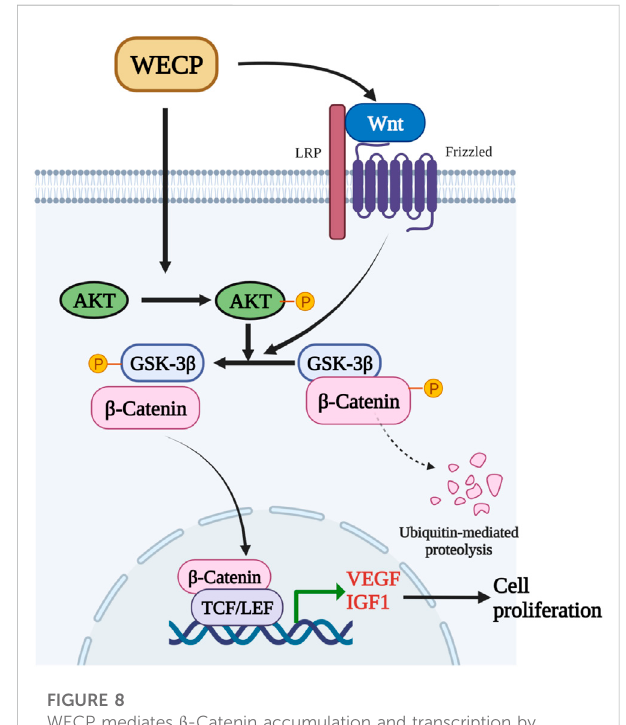
WECP mediates β -Catenin accumulation and transcription by promoting Akt and GSK3 β phosphorylation. β -Catenin translocates to the nucleus where it enhances LEF1 factor transactivation and upregulates VEGF and